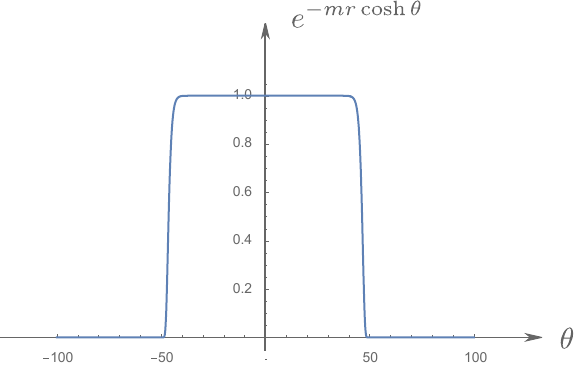
Figure 4 . The behavior of factor e (cid:0) mr cosh (cid:18) , here we take mr = 10 (cid:0) 20 , and (cid:0) log( mr ) (cid:25) 46 : 05. we can write the exponential factor in the second line of (4.6) as e (cid:0) mr cosh( (cid:18) k + (cid:28) ) . This